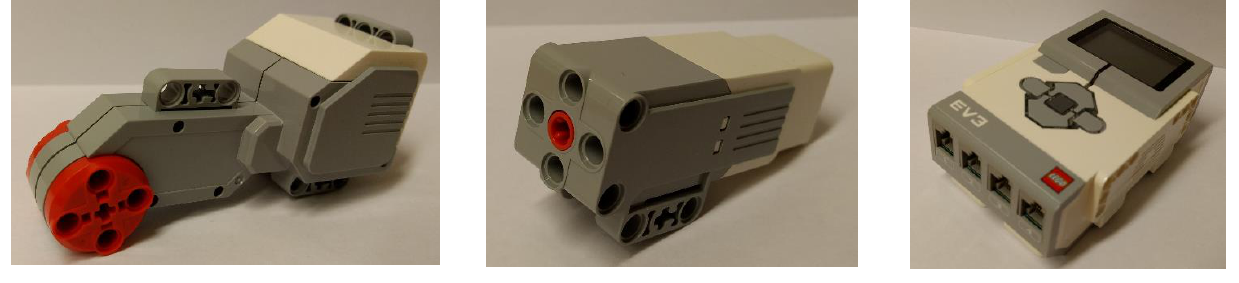
Figure 6. The EV3 Large Motor sensor. Figure 7. The EV3 Medium Motor sensor. Figure 8. The EV3 intelligent brick.